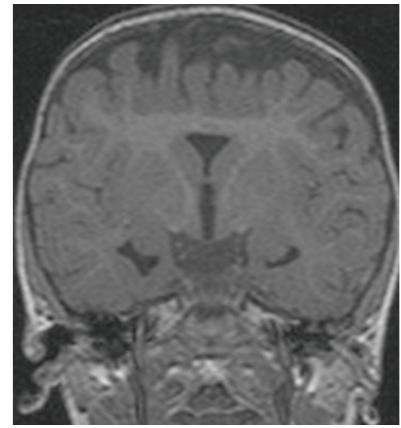
Fig. 5. TOF MRA of Circle of Willis and intracranial